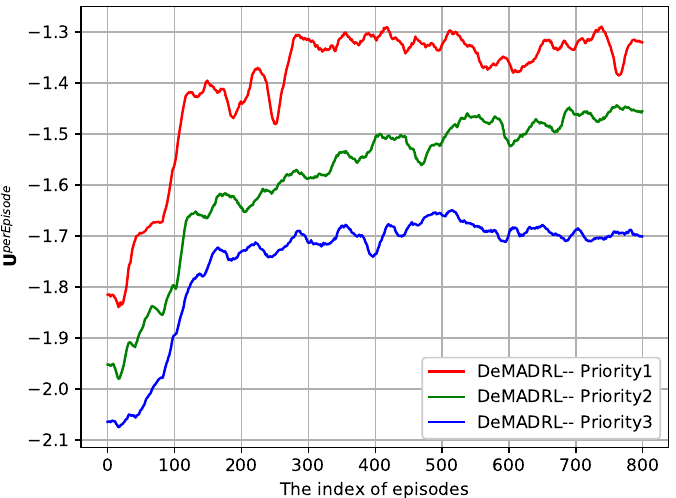
Figure 5. Structure of the multi-agent deep reinforcement learning